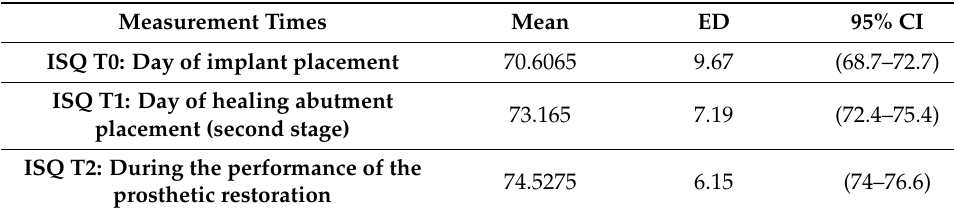
Table 6. ISQ (implant stability quota) values.